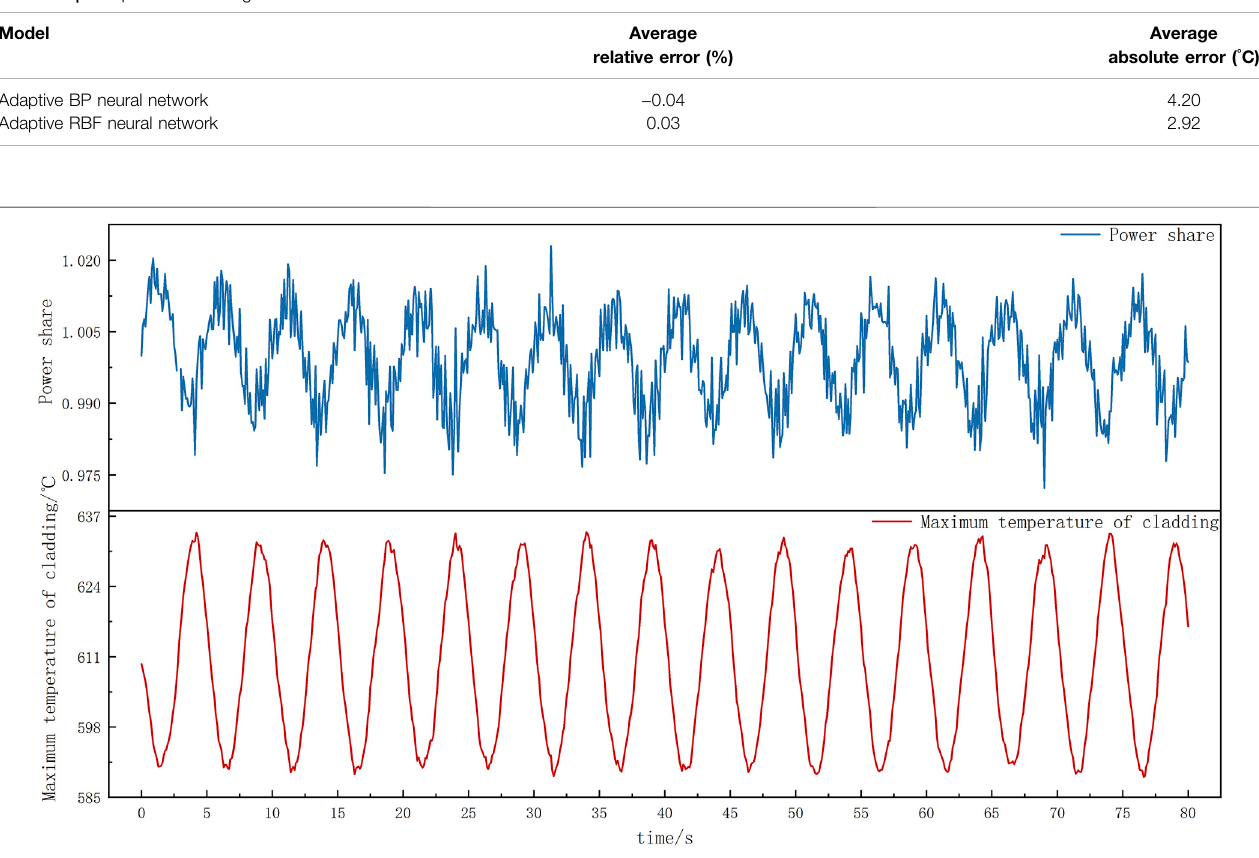
FIGURE 10 | Variation of reactor power and cladding maximum temperature within 80s.